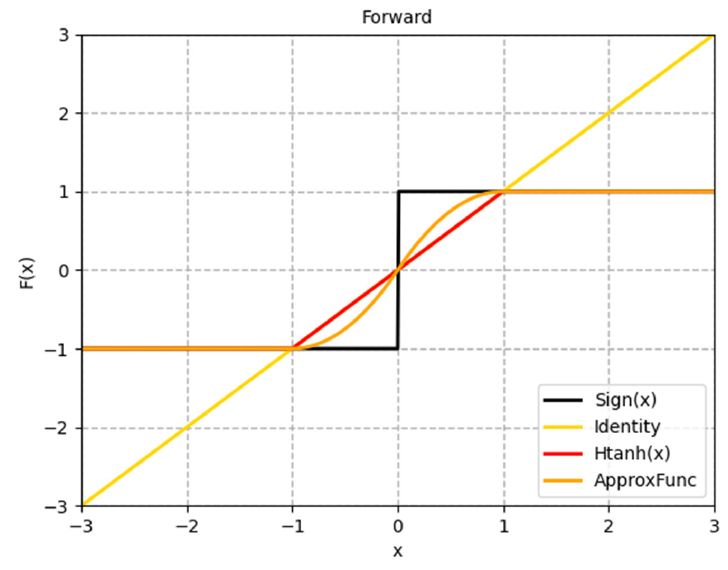
Figure 3. Common approximation of a sign function. The first one uses the identity function (i.e., y = x ) to directly transfer the gradient information of the output value to the input value, completely ignoring the effect